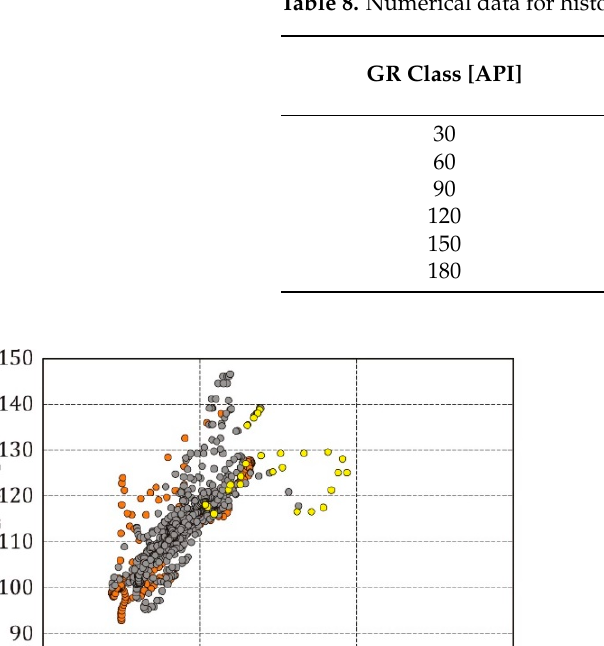
Table 8. Numerical data for histograms in Figure 8c.